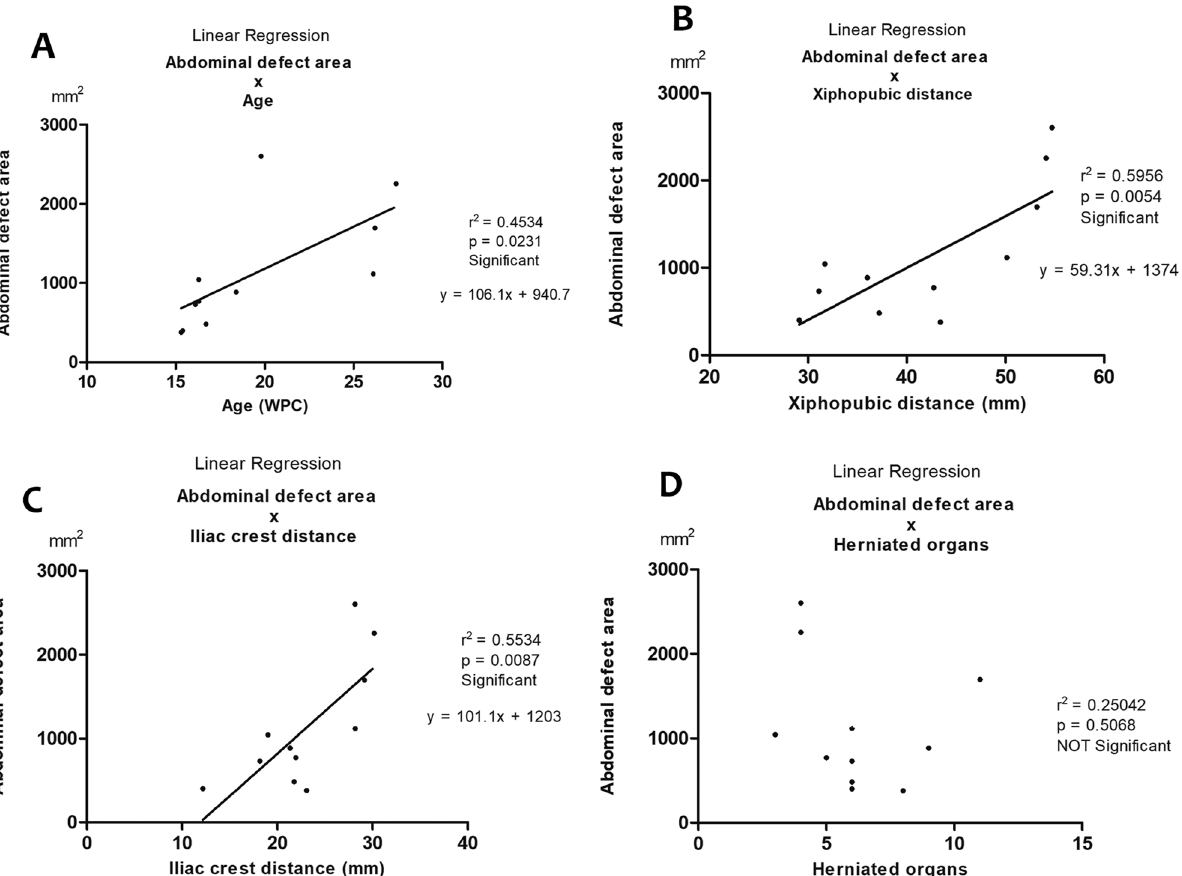
Figure 2. ( A ) Linear regression analysis of Abdominal Defect Area (ADA) versus Fetal Age showing that the ADA increased significantly and positively with fetal age (r 2 = 0.4534; p = 0.0231); ( B ) linear regression analysis of ADA versus Xiphopubic Distance (XPD) showing that the ADA increased significantly and positively with the XPD (r 2 = 0.5956; p = 0.0054); ( C ) linear regression analysis of ADA versus Iliac Crist Distance (ICD) showing that the ADA increased significantly and positively with the ICD (r 2 = 0.5534; p = 0.0087); ( D ) linear regression analysis of ADA versus Number of Herniated Organs showing that the area of abdominal defect (hole) did not have significant correlation with the number of herniated organs (r 2 = 0.25042; p =